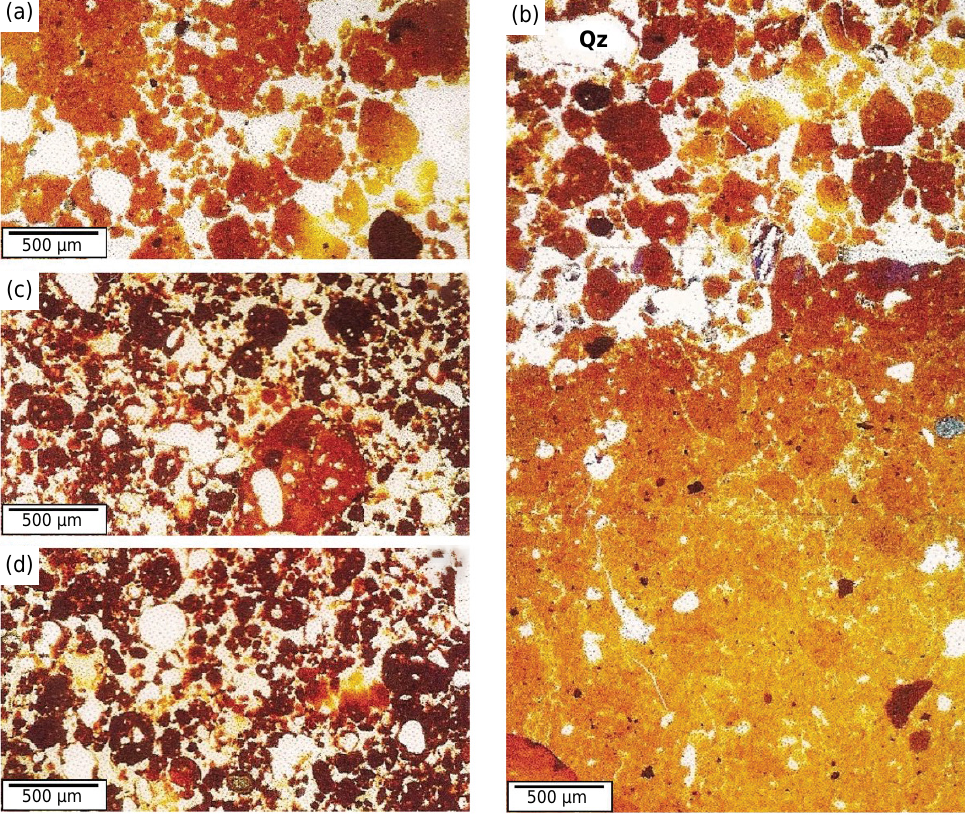
Figure 7. Photomicrographs of the Ap horizon (a) and Bw 2 horizon (b) in the P 4 - Geric Acric Gibbsic Ferralsol (Clayic, Dystric), and of Bw 2 horizon (c and d) in the P 5 - Acric Rhodic Ferritic Ferralsol (Clayic, Dystric, Humic); Patrocínio topolithosequence. Bimodal pattern of aggregates, with high porosity (a), abundant biological channels in the strongly well-structured micromass, partially filled with welded aggregates, with quartz grains, Fe/Ti/Al nodules and perovskite grains (b), and inclusions of rounded sand-sized quartz grains, Ti/Fe nodules, perovskite grains, biological channels with yellowish clay infillings and some dispersed clay between aggregates (c and d). Qz: